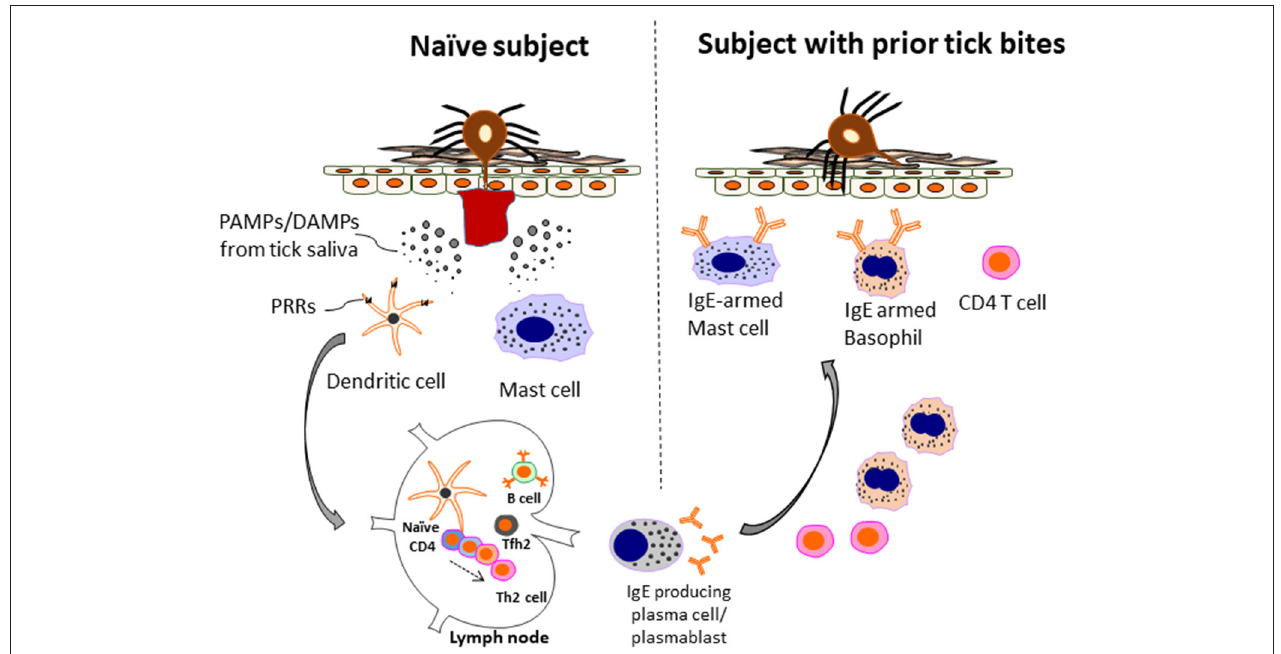
FIGURE 2 | Model of allergic immunity in anti-tick defense. A host without prior tick bites (naïve subject) lacks protective immunity and can have a prolonged tick feed. However, during this initial exposure Th2 cells and IgE-producing B cells are generated. The mechanism includes recognition of PAMPs/DAMPs present in tick saliva by PRRs (e.g., TLR4 and others) present on innate immune cells, such as dendritic cells. In turn, anti-tick IgE binds to mast cells, and basophils via the Fc ε R1 receptor expressed selectively by these cells. Th2 cells and basophils are recruited to the skin. IgE-armed basophils play a particularly important role in acquired tick defense (ATR) to subsequent tick bites. The amount of IgE and number of basophils can be enhanced after repetitive tick bites. As a consequence, both tick feeding and pathogen transmission are impaired. The anti-tick response can include IgE to a -Gal, but also other tick antigens that have yet to be characterized. Adapted by permission from Springer Nature, Current Allergy and Asthma Reports, Galactose- α -1,3-galactose: Atypical food allergen or model IgE hypersensitivity; Wilson et al. (56).